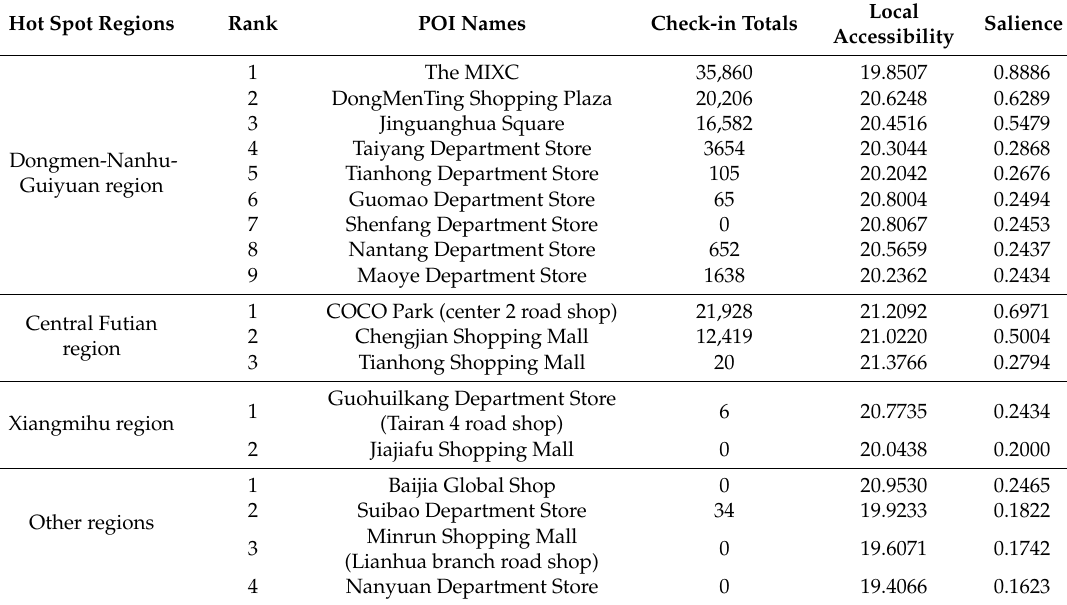
Table 4. POIs ranked by